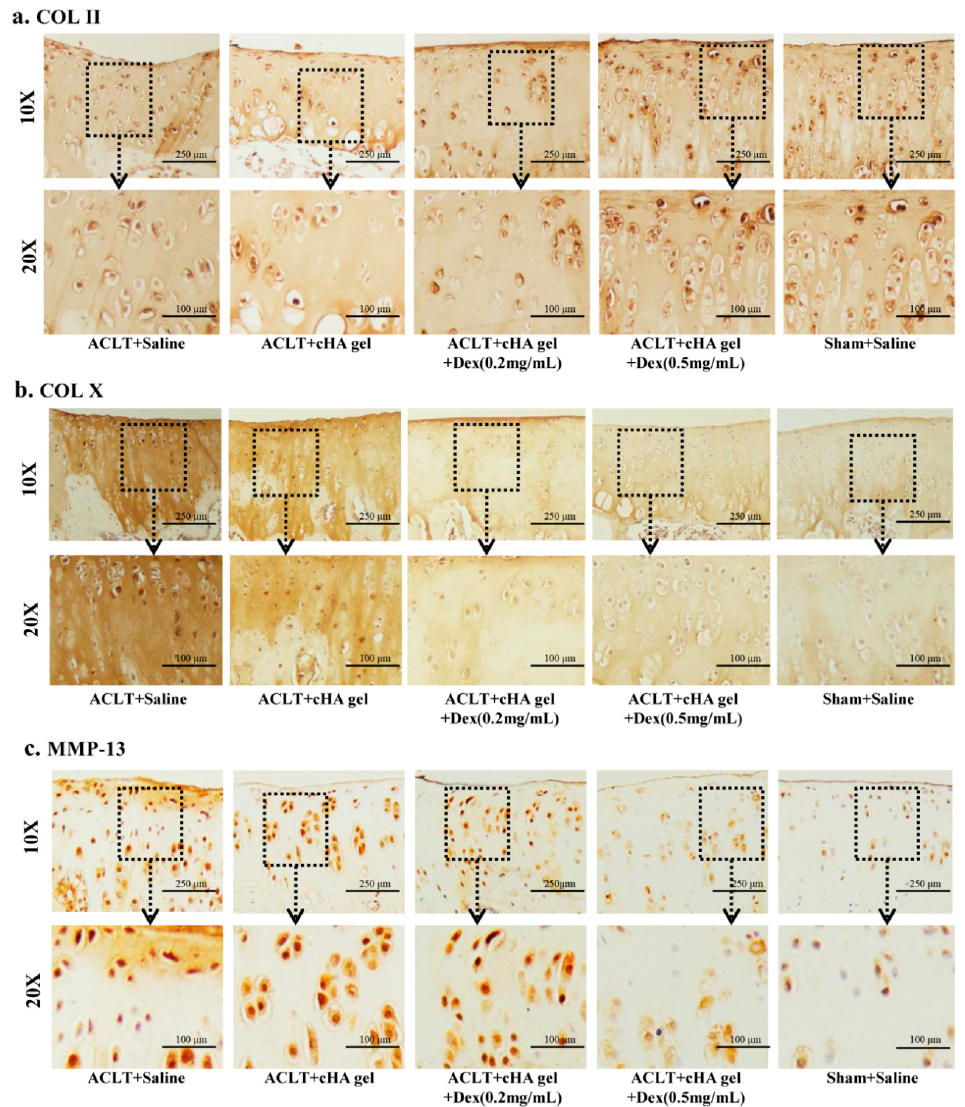
Figure 4. Intra-articular cross-linked hyaluronic acid-dexamethasone (cHA-Dex) hydrogel injections increased type II collagen (COL II) expression, while it decreased type X collagen (Col X) and matrix metalloproteinase 13 (MMP-13) expressions in cartilage, histologically. Immunohistochemical staining was used for COL II, COL X, and MMP-13. Positive signals are indicated by brown staining. Increased COL II expression ( a ), and decreased COL X ( b ) and MMP-13 ( c ) expressions were detected in the articular cartilage of cHA-Dex gel-treated animals comparing with the ACLT + saline or cHA only groups. The images obtained under the 10×, 20× objective lenses respectively.